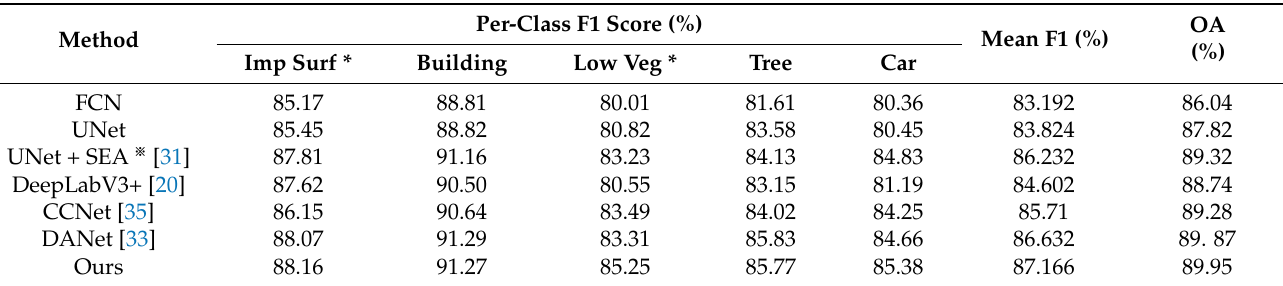
Table 3. Comparison with the state-of-the art on the Potsdam Dataset.